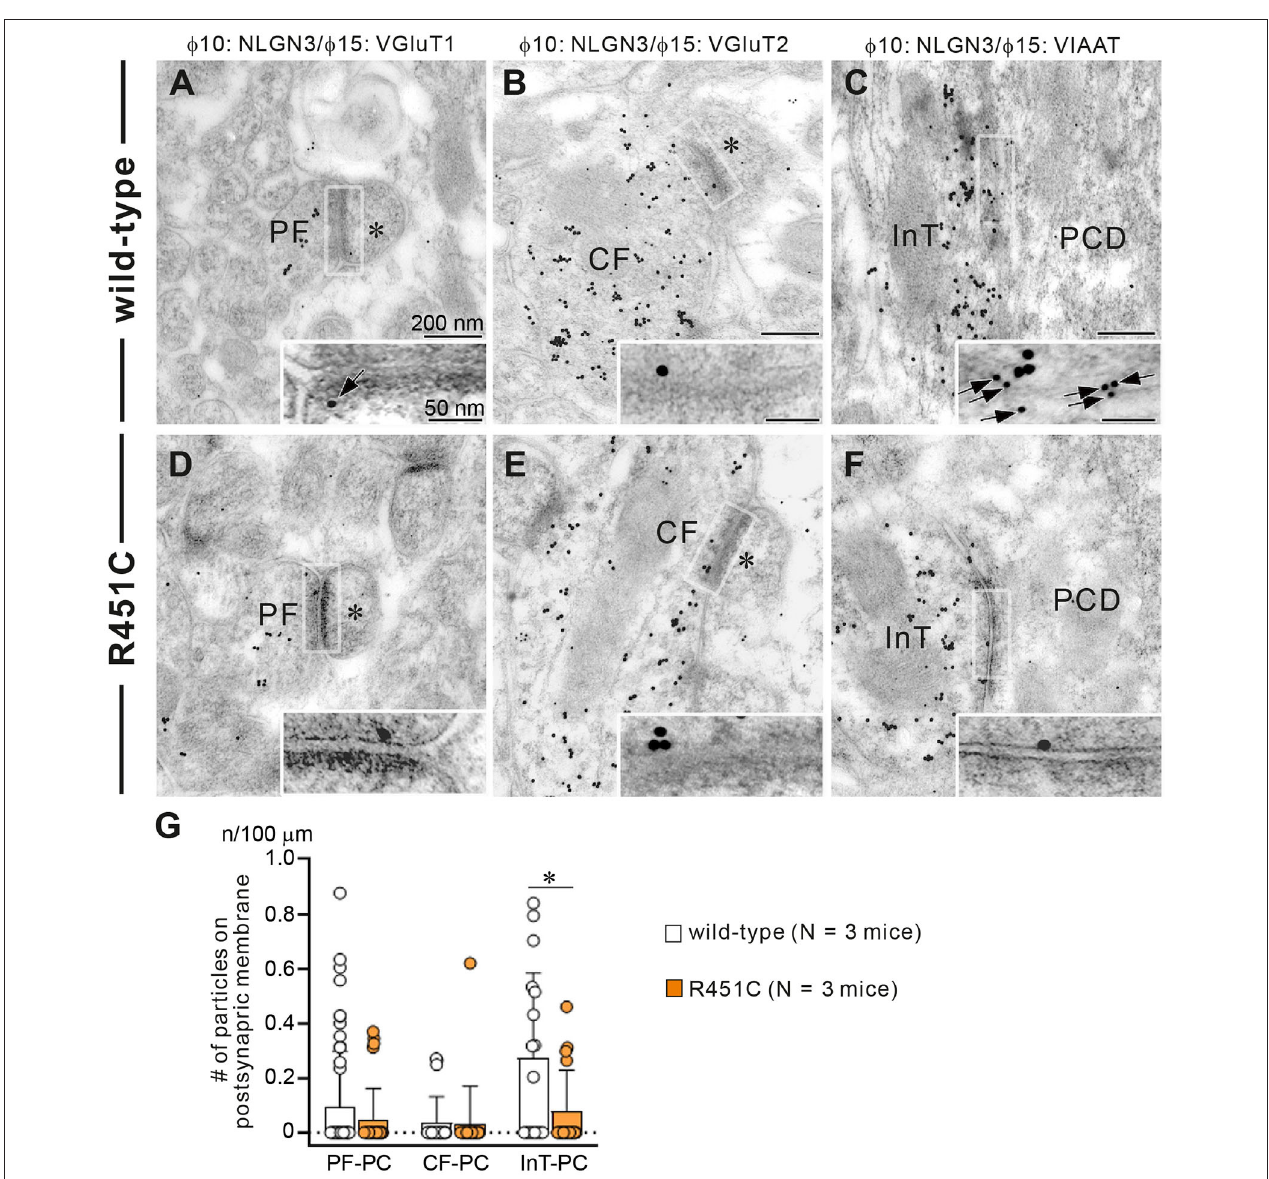
FIGURE 4 | Reduced NLGN3 expression at inhibitory interneurons to PC synapses in NLGN3-R451C mutant mice. (A–F) Post-embedding immunogold electron microscopy for NLGN3 in wild-type (A–C) and NLGN3-R451C mutant (D–F) mice. (A,D) Indicate PC spines (asterisks) contacting to PF presynaptic terminals labeled for VGluT1. (B,E) Indicate PC spines (asterisks) contacting to CF presynaptic terminals labeled for VGluT2. (C,F) Indicate PC dendrites (PCD) contacting to presynaptic terminals of inhibitory interneurons (InT). Scale bars, 200nm and 50nm for inset. (G) Summary bar graphs showing the average number of NLGN3 immunogold particles (n) per 100 µ m of the postsynaptic membrane of PF-PC, CF-PC, and InT-PC synapses in wild-type (open circles and columns, N = 3 mice aged 30–35 days) and NLGN3-R451C mutant (orange circles and columns, N = 3 mice aged 30–35 days) mice. Data are expressed as mean ± SD. p = 0.33 for PF-PC, p = 0.61 for CF-PC and * p = 0.035 for InT-PC synapses by Mann-Whitney U